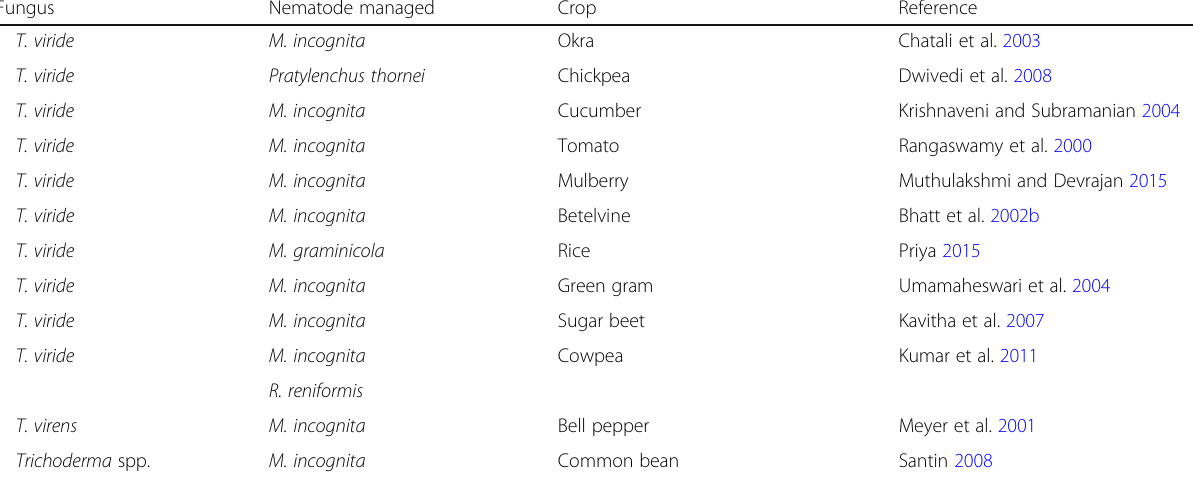
Table 4 Biocontrol agents of fungal species targeting nematodes on economic crops (Continued)